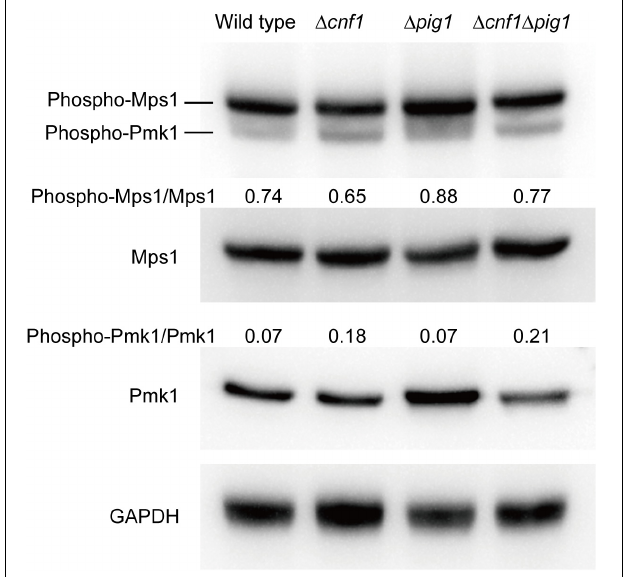
FIGURE 6 | Analysis of phosphorylation level of Mps1 and Pmk1 in the wild-type 70-15 and its derived mutants ( (cid:49) pig1 , (cid:49) cnf1 , and (cid:49) cnf1 (cid:49) pig1 ) by western blot. Phosphorylated Pmk1 and Mps1 were detected using an anti-Phospho-p44/42 MAPK antibody. Total Pmk1 and Mps1 were detected using an anti-ERK1/ERK2 MAPK antibody. GAPDH was detected using an anti-GAPDH antibody. Numbers represent the protein contents of phospho-Pmk1 or phospho-Mps1 relative to total Pmk1 or Mps1.